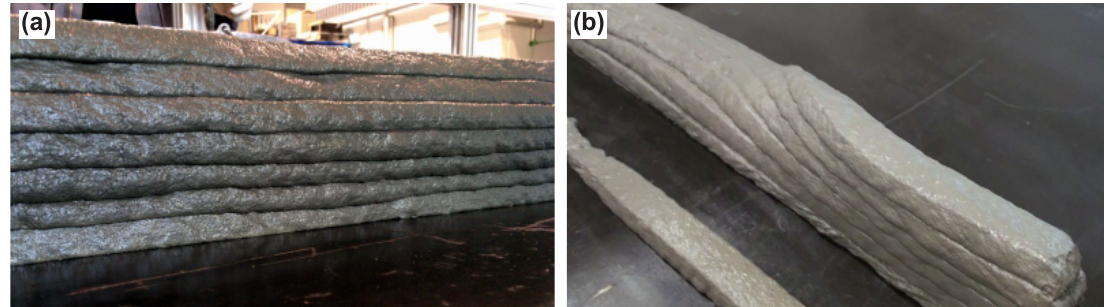
Figure 9. Seven-layer printed specimen with interlayer time interval of one minute: ( a ) Mixture B; and ( b ) Mixture D.